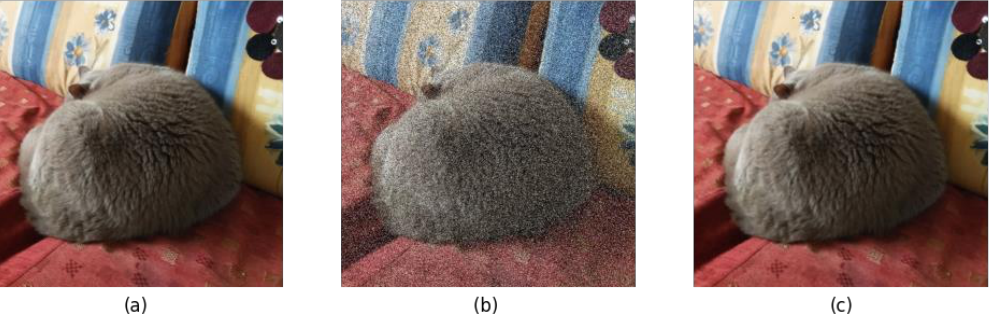
Figure 6. ( a ) Original image; ( b ) Original image with added salt-and-pepper noise; ( c ) Image B after the application of the median filter with window size 5.